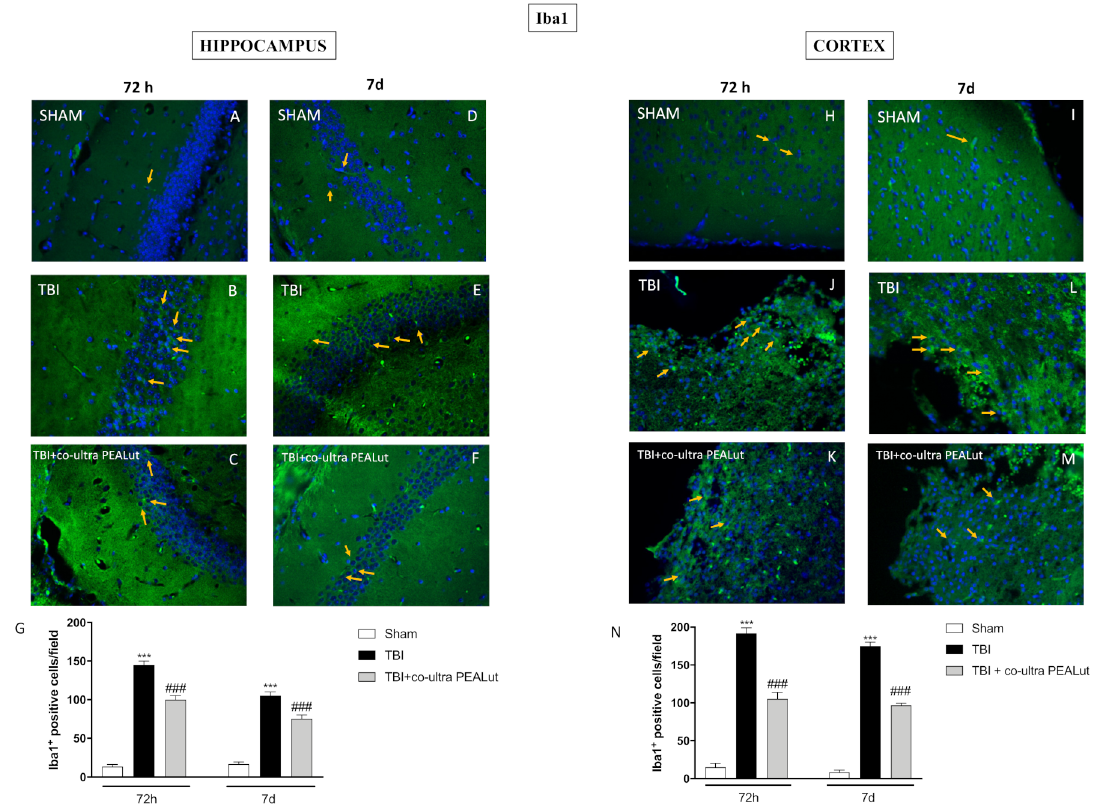
Figure 6. Co-ultra PEALut administration reduced microgliosis. Iba1 + cells were significantly increased in the hippocampus ( B , E , G ) and cortex ( J , L , N ) of TBI mice, compared to respective sham groups ( A , D , G and H , I , N ). Co - ultra PEALut treatment reduced Iba1 + cells expression, at both 72 h and 7 d, in the hippocampus ( C , F , G ) and cortex ( K , M , N ). Magnification 40 × . Yellow arrows indicate the positive staining for GFAP. Data are expressed as Mean ± SEM from N = 10 mice for each group. One-way ANOVA test. *** p < 0.001 vs. corresponding Sham group; ### p < 0.001 vs. corresponding